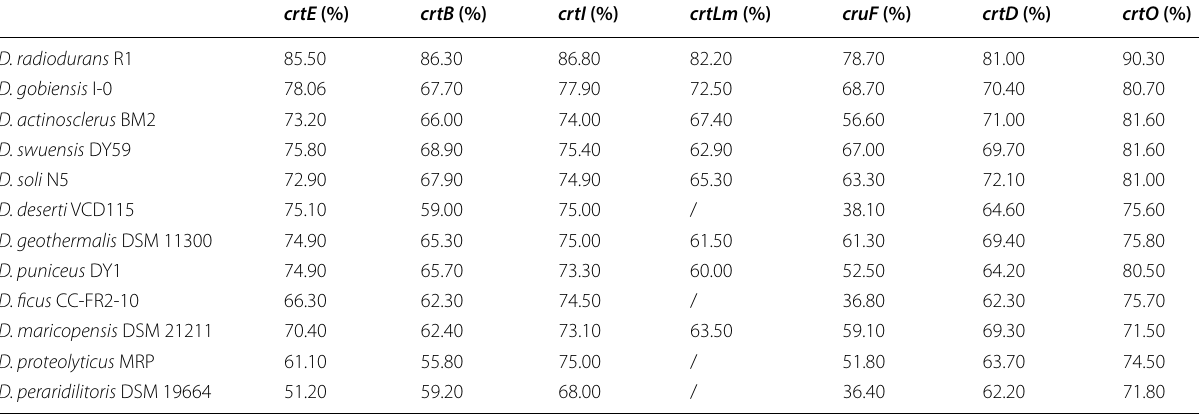
Table 3 Percentages of sequence identity of carotenoid biosynthesis gene sequences between D. wulumuqiensis R12 and other Deinococcus